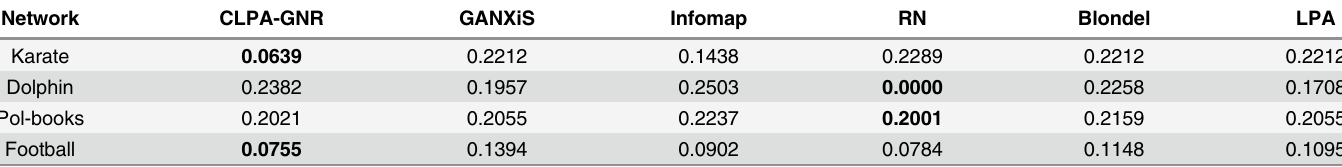
Table 6 depicts the NVI of 4 real-world networks with ground truth communities. CLPA-GNR performs very well by having the best detection performance in both the Karate and the Foot- ball networks. Although RN gives the best detection for the Pol-books network, the result of the CLPA-GNR is equivalent to that for RN. Table 6. The NVI of real-world networks with ground truth communities. Bold values are the best detection algorithm for each network.